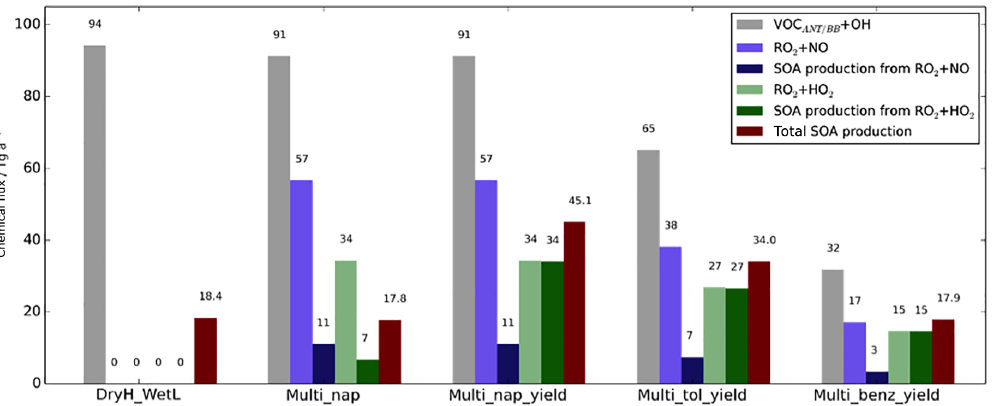
Figure 7. Global annual-total reaction fluxes and total SOA production rate from anthropogenic and biomass burning hydrocarbons for the simulations described in Table 3. The global annual-total VOC ANT / BB emission rate, of 176(VOC ANT / BB )a − 1 , is identical across all simulations.